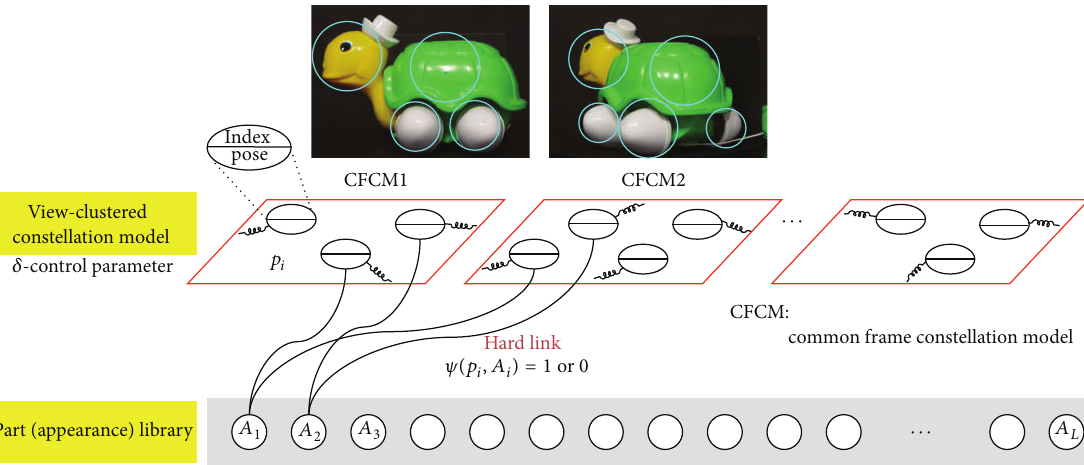
Figure 5: Shared feature-based common frame constellation models (CFCMs) which are view